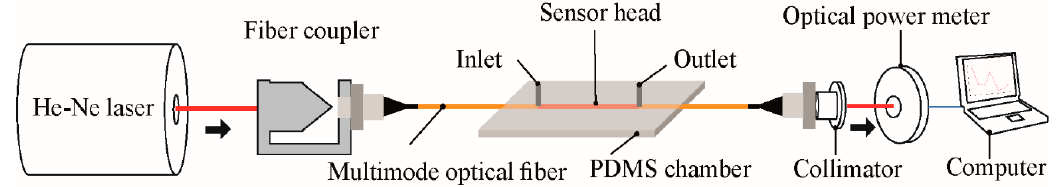
Figure 5. Experimental setup for the fiber-based sensor system.